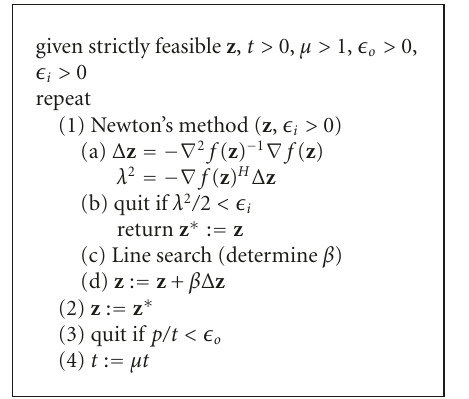
Algorithm 1: The barrier method.